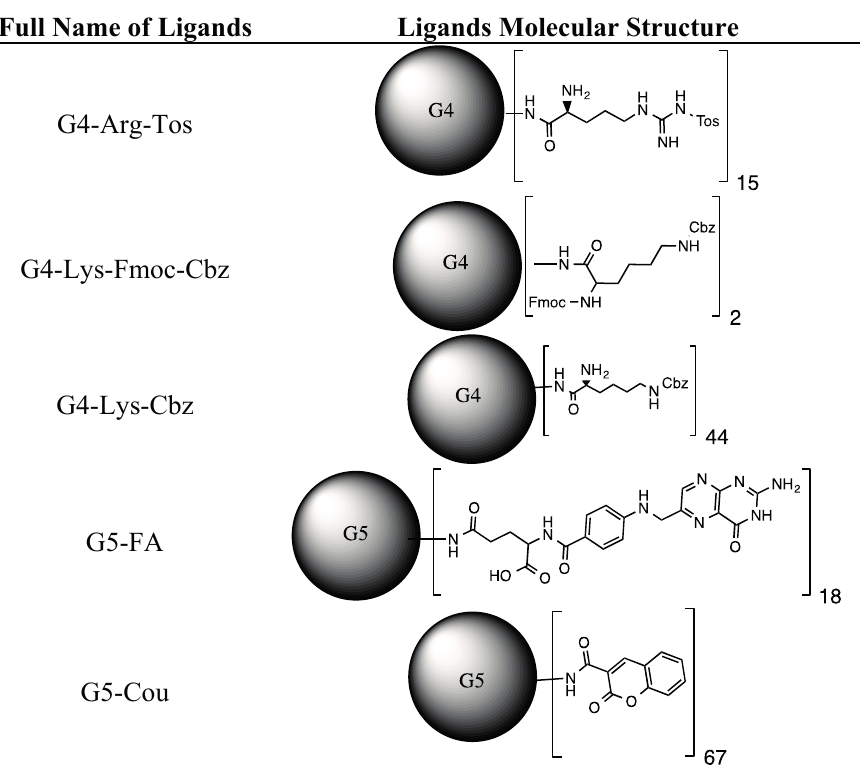
Table 1. Full names of ligand and molecular structures of the different PAMAM derivatives synthesized.